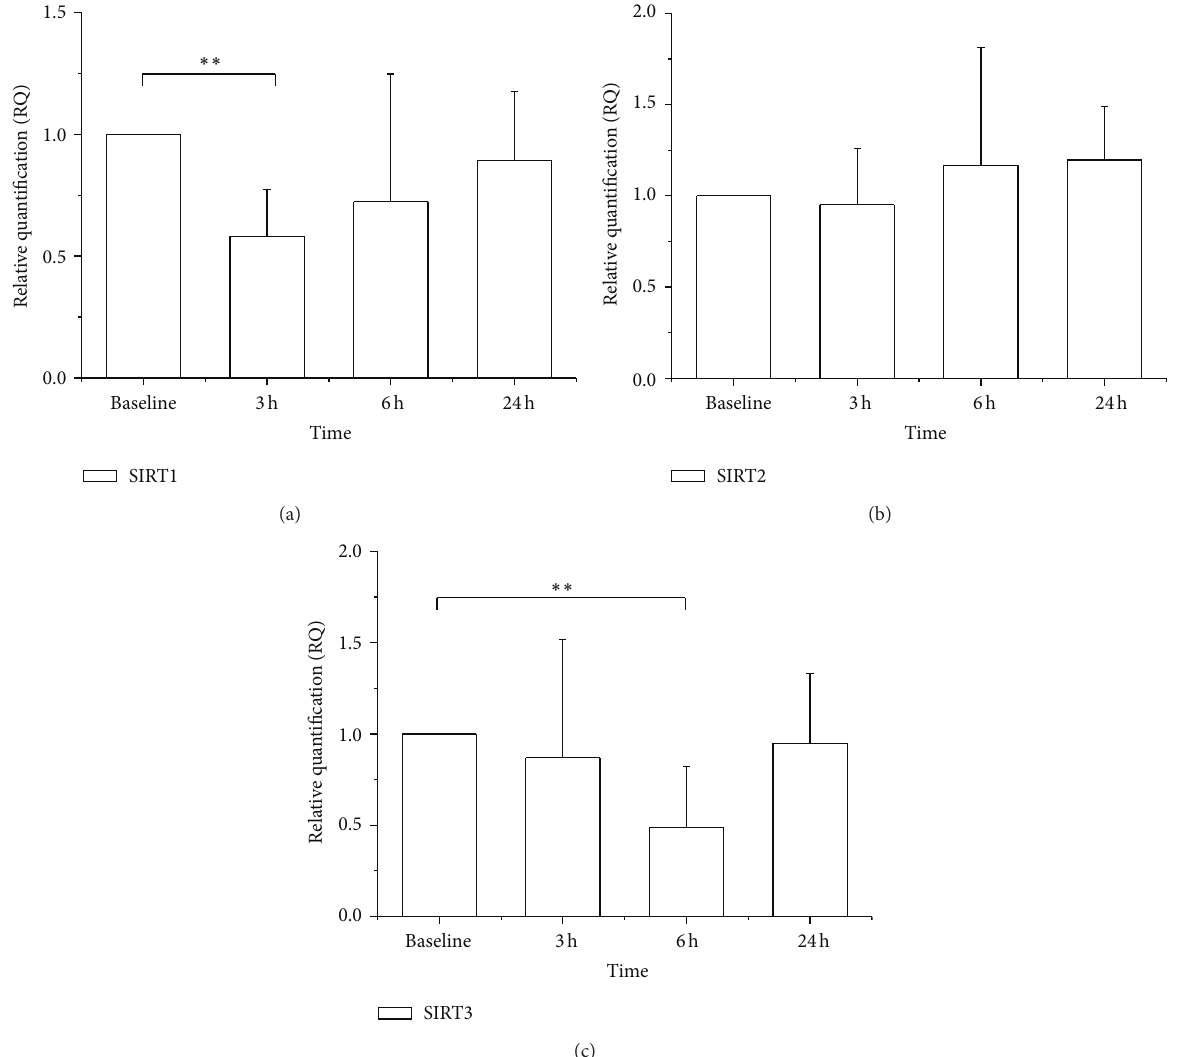
Figure 1: SIRT1, SIRT2, and SIRT mRNA expressions in PBMC following LPS administration. (a) SIRT1 mRNA was decreased 3 hours after LPS challenge (RQ 0.58; 𝑃 < 0.01 ). (b) SIRT2 mRNA was not altered within 24 hours after LPS. (c) SIRT3 mRNA was decreased 6 hours after LPS challenge (RQ 0.49; 𝑃 < 0.01 ). Results are mean ± SD ( 𝑛 = 7